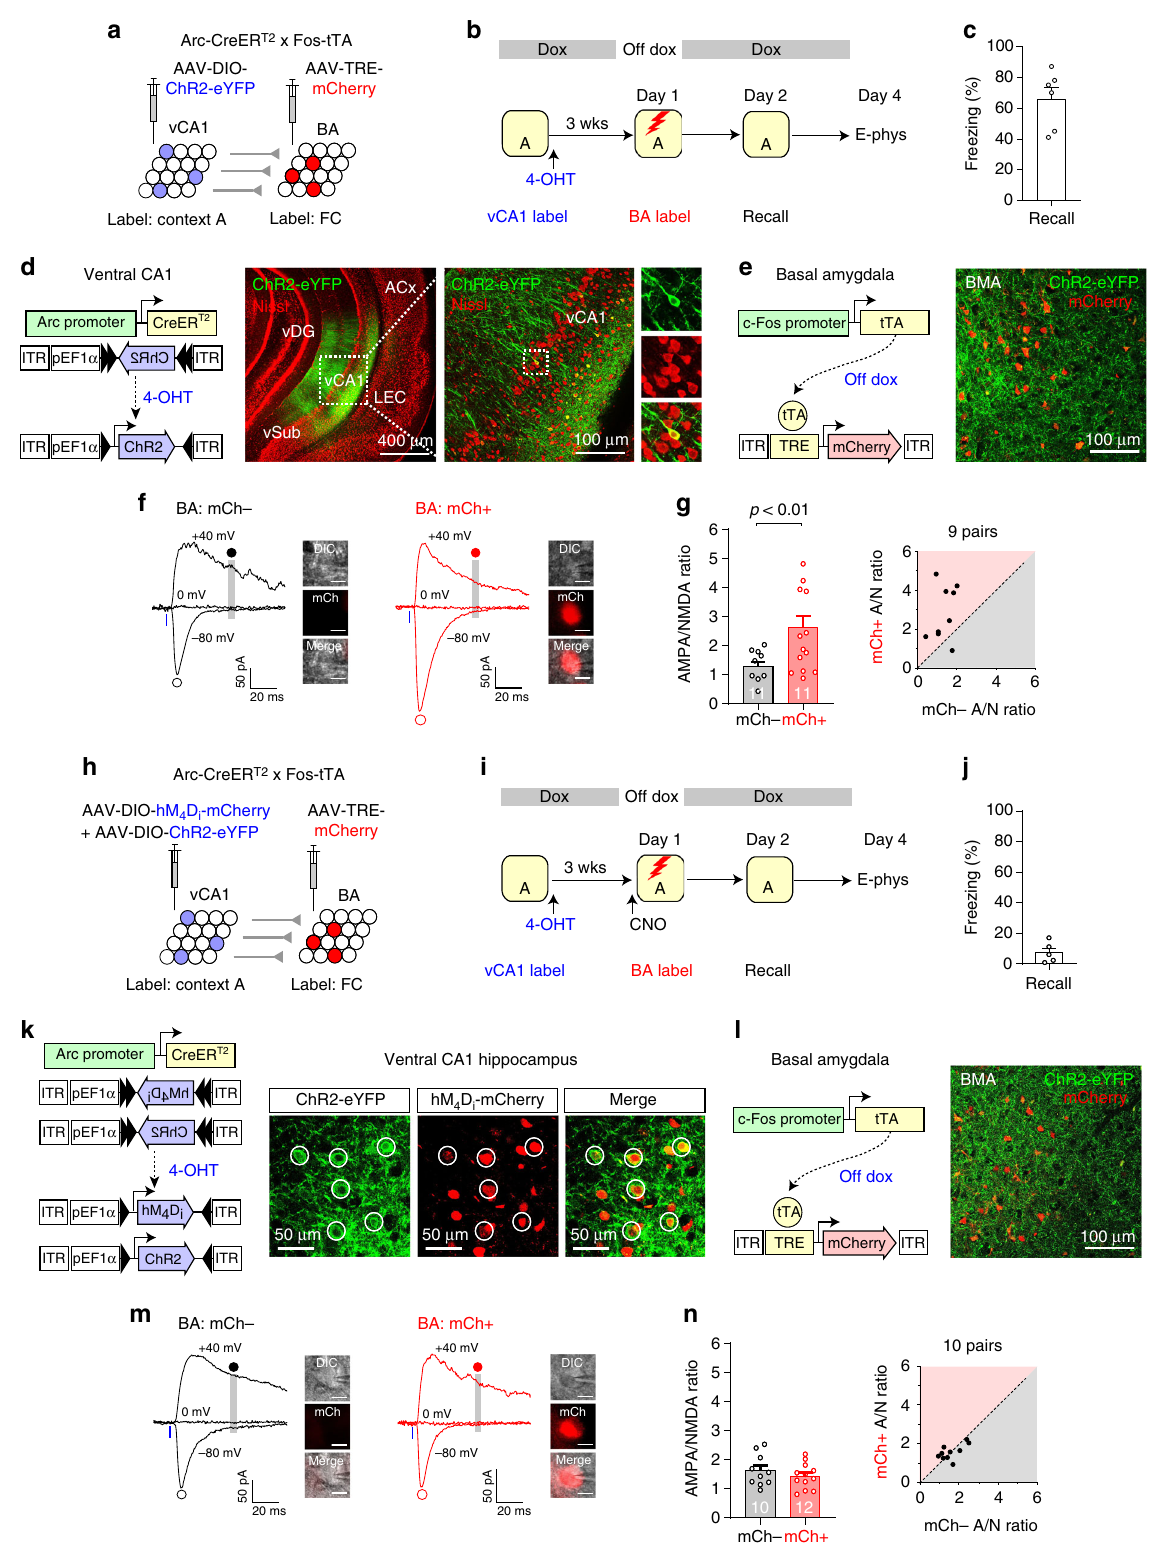
Virus constructs . The recombinant adeno-associated viruses (AAVs) were pack- aged by the Vector Core at the University of North Carolina. The AAV titers were 4.3× 10 12 genome copies (GC)/mL for AAV5-pCaMKII α -eYFP, 6.5× 10 12 GC/mL for AAV5-pEF1 α -DIO-eYFP, 5.3× 10 12 GC/mL for AAV5-pEF1 α -DIO-mCherry, 4.0× 10 12 GC/mL for AAV5-pEF1 α -DIO-hM 4 D i -mCherry, 5.5× 10 12 GC/mL for AAV5-pSyn-DIO-hM 4 D i -mCherry, 4.6× 10 12 GC/mL for AAV5-pCaMKII α